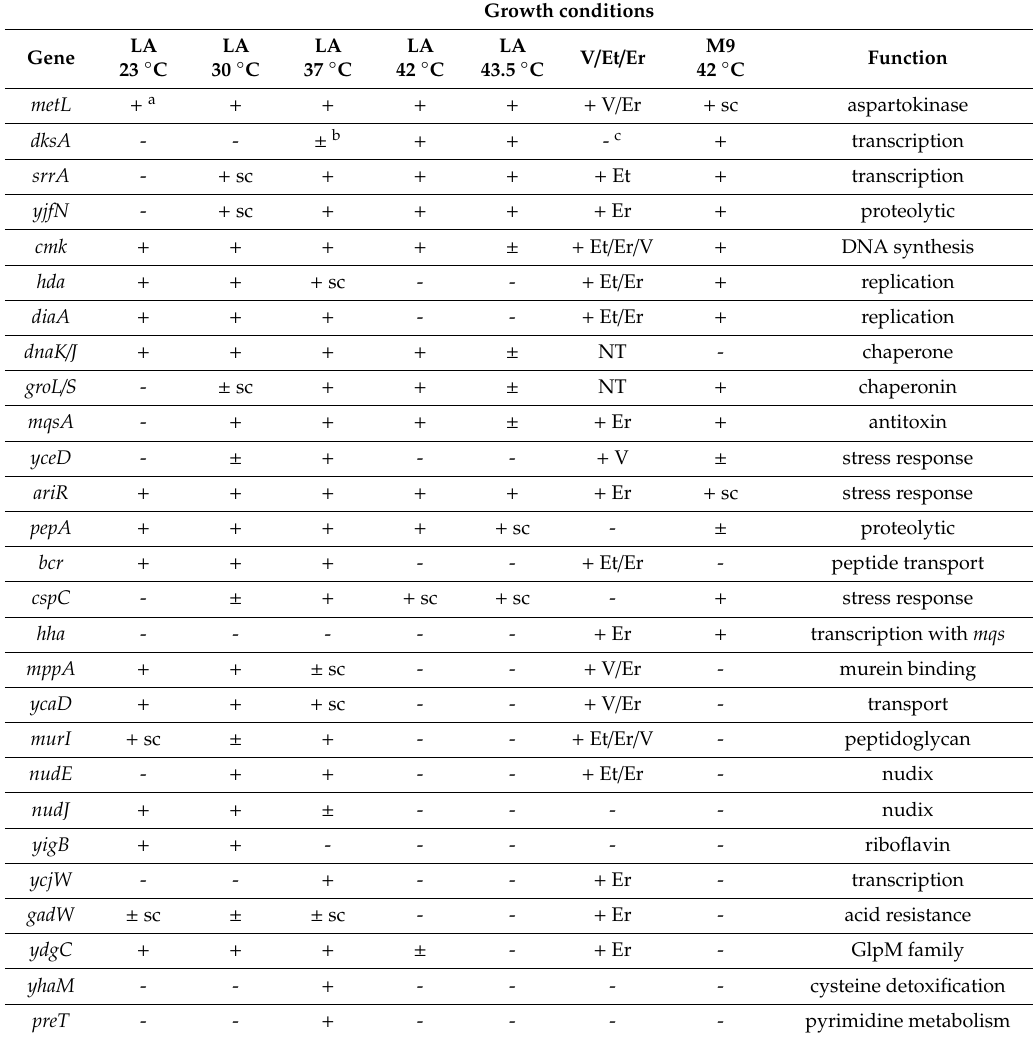
Table 2. Multicopy suppressors that restore the growth of ∆ 6 ppi strains under di ff erent